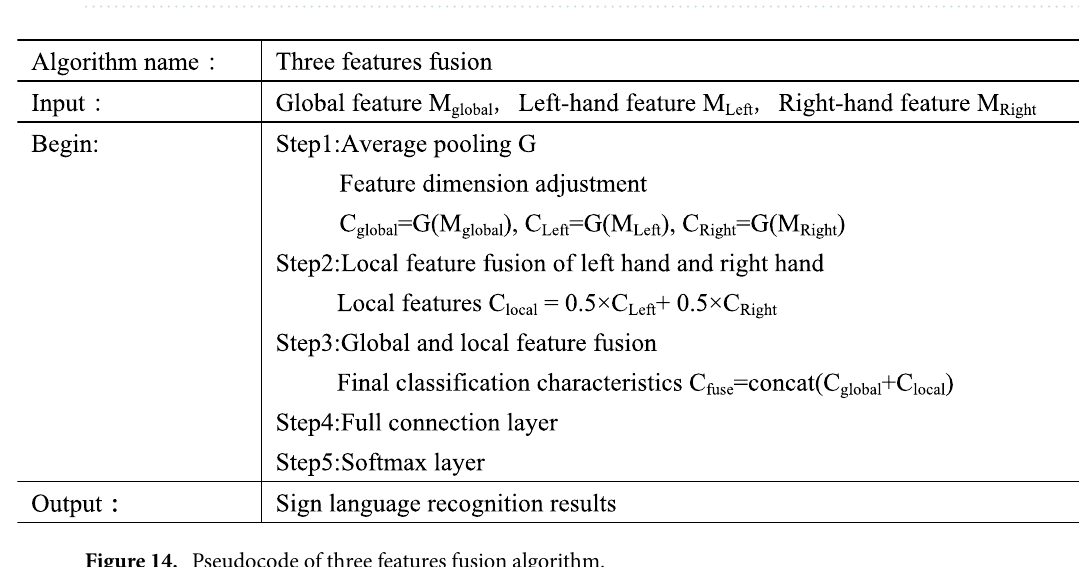
Figure 13. Left-hand and right-hand region image sequences.